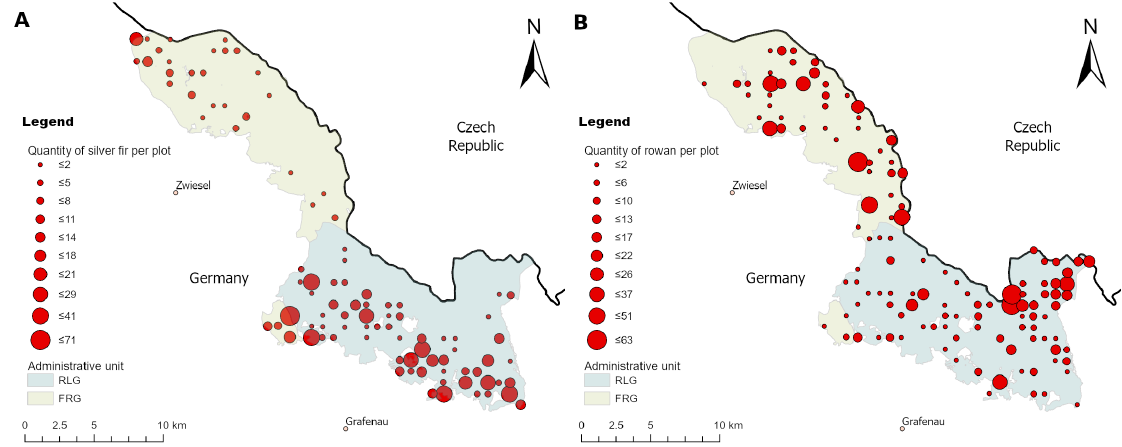
Figure A10. Spatial distribution of the silver fir ( A ) and the rowan ( B ) in our study